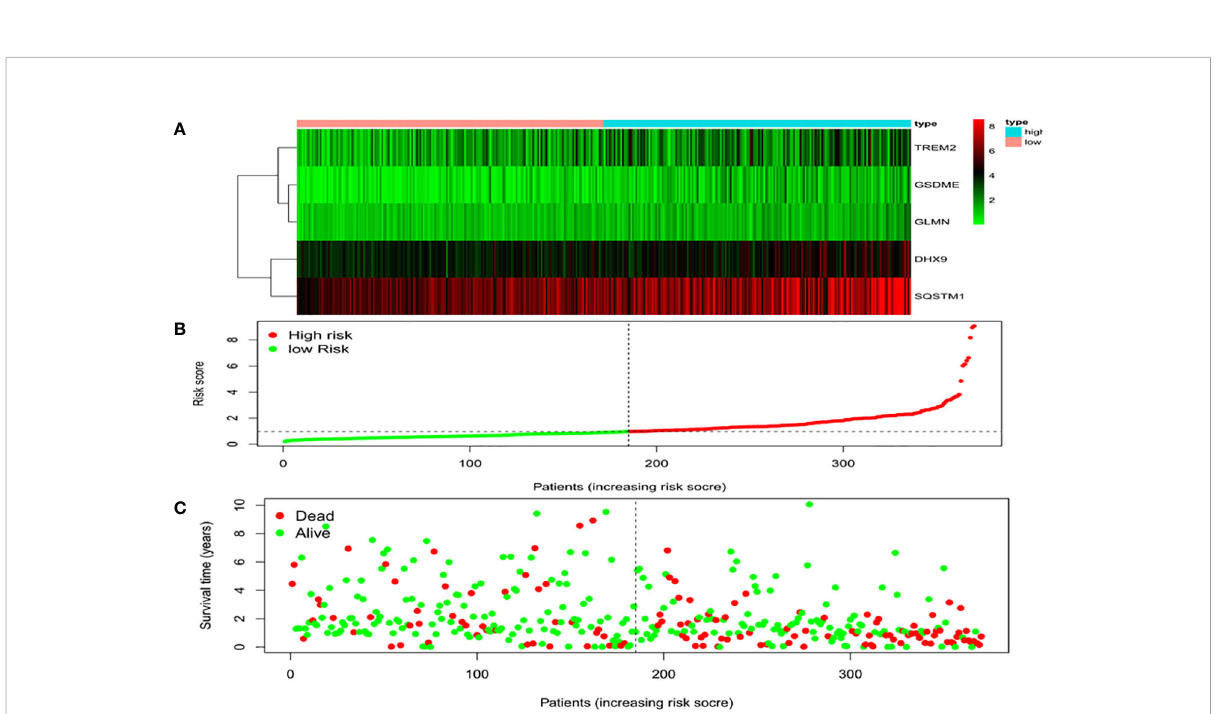
FIGURE 6 Characteristics of the prognostic gene signatures. (A) The heatmap of the expression pro fi les of the ten DEGs in the high- and low-risk HCC patients. The abscissa represents risk types, the ordinate represents the gene. (B) Distribution of risk scores of the high- and low-risk HCC patients. The abscissa represents the patients (increasing risk score), the ordinate represents the risk score. (C) Scatter plot shows the correlation between survival time and risk score. The abscissa represents the patients (increasing risk score), the ordinate represents survival time